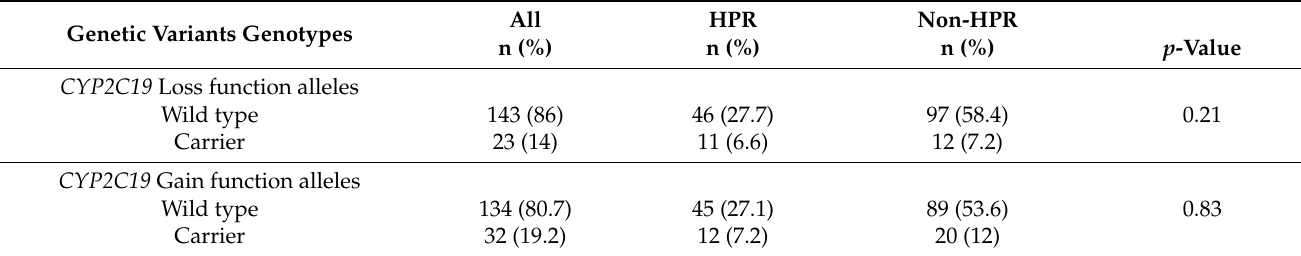
Table 2. Non-high platelet reactivity (HPR) and HPR statistical